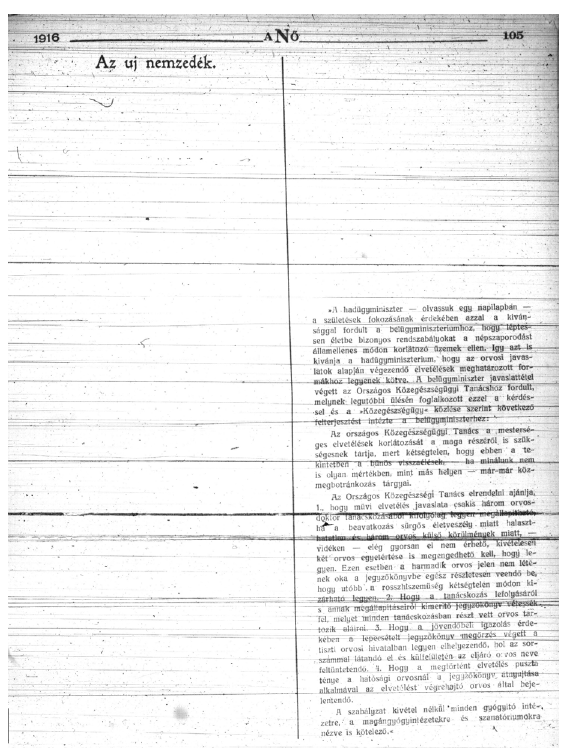
Fig. 3 Censored content in a 1916 issue of A